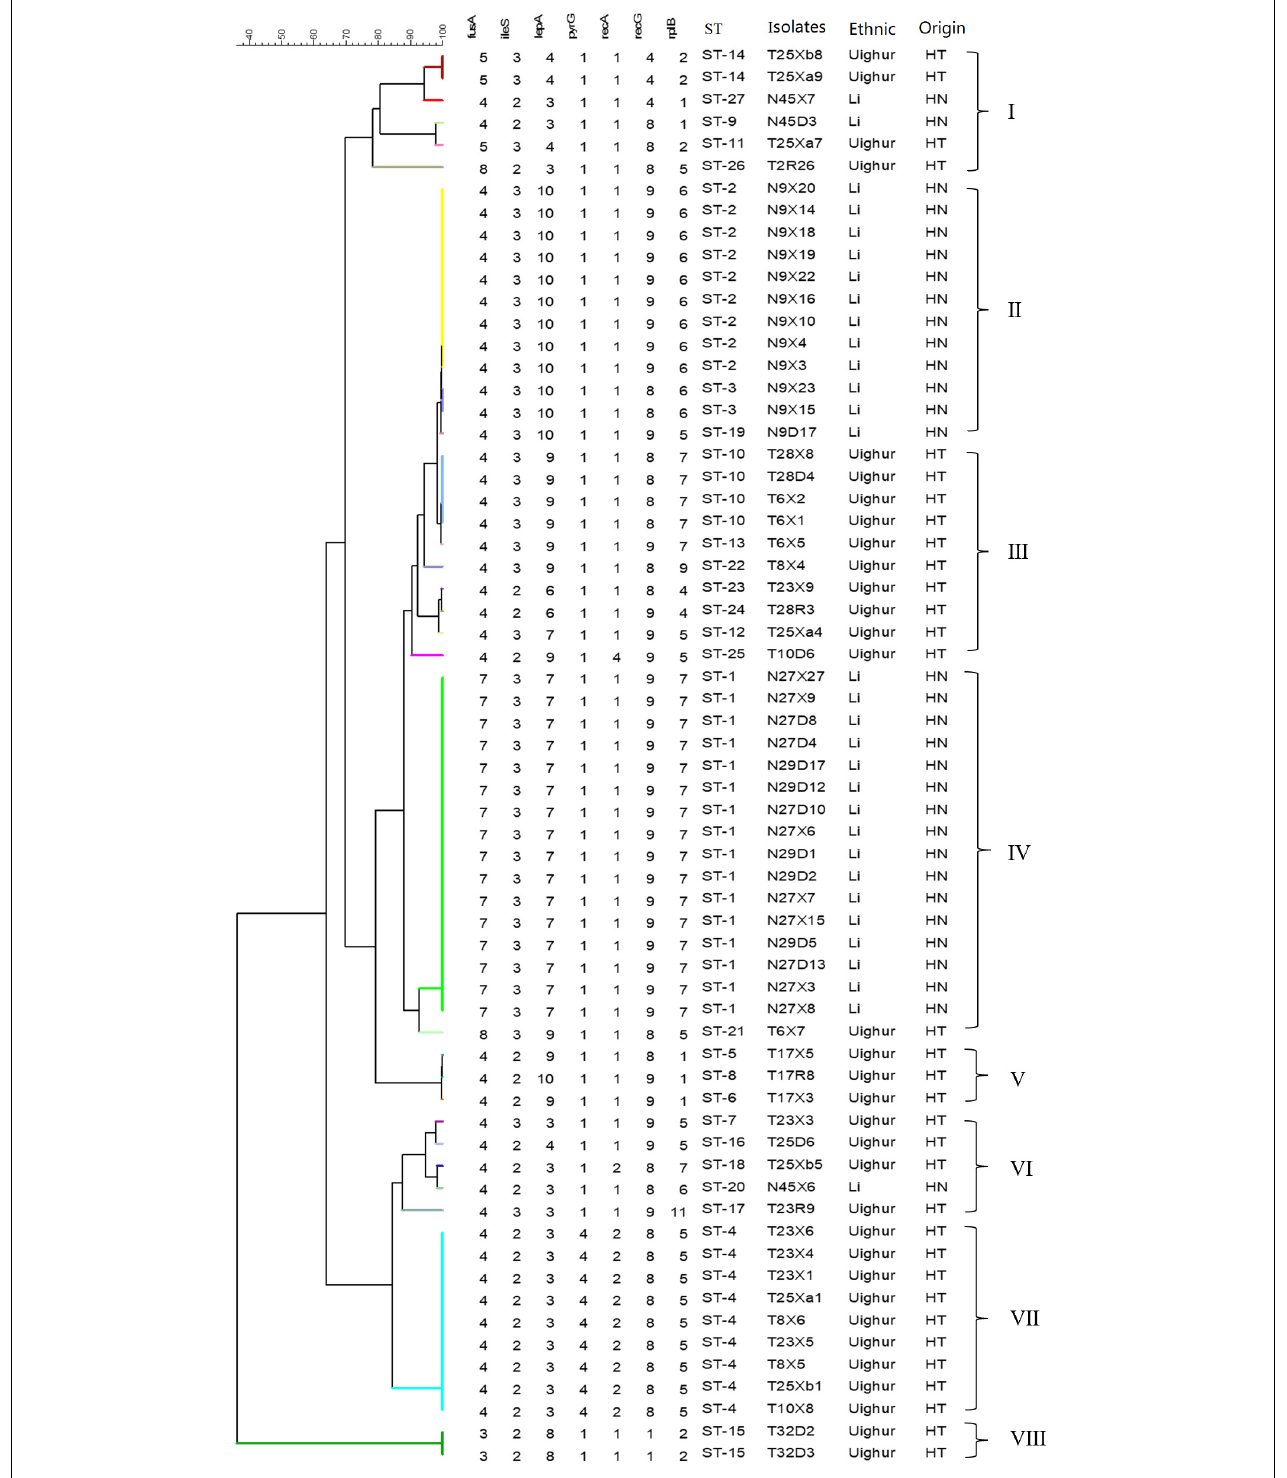
FIGURE 2 | An UPGMA dendrogram of ST of 64 representative L . paracasei strains. The different colors represent the different STs. Each row shows in turn the number of alleles, ST, and isolated location for each strain.